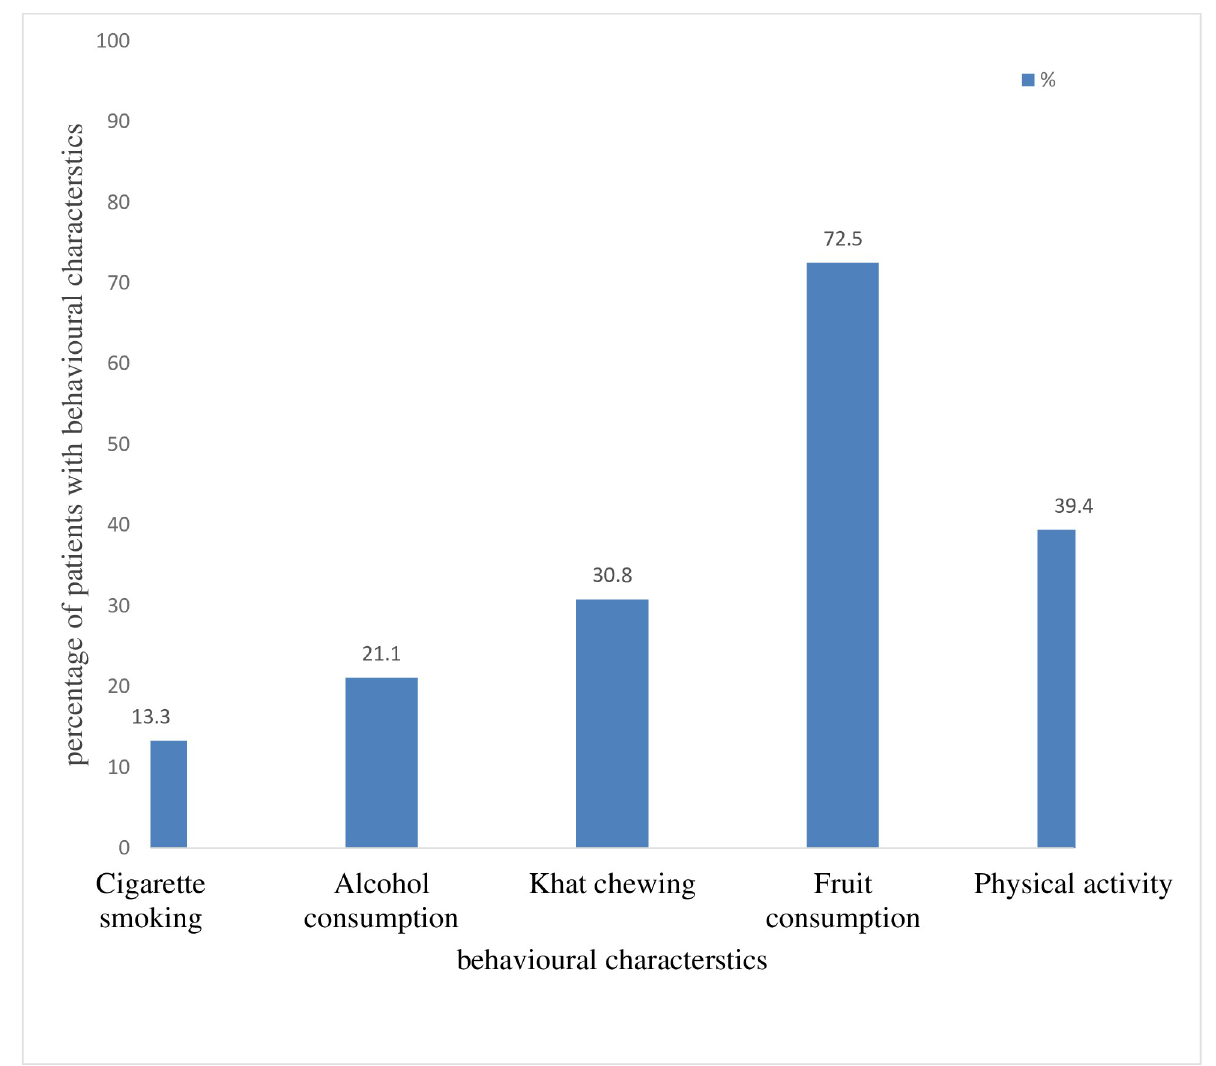
Fig 1. Behavioral factors among respondents admitted to medical ward with metabolic syndromes, in Jimma Medical Center, South west Ethiopia from April-May